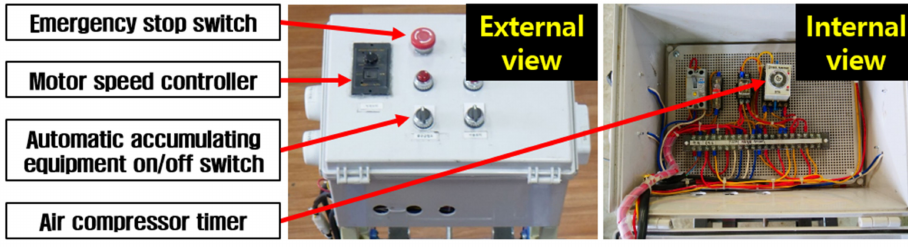
Figure 10. View of control box.